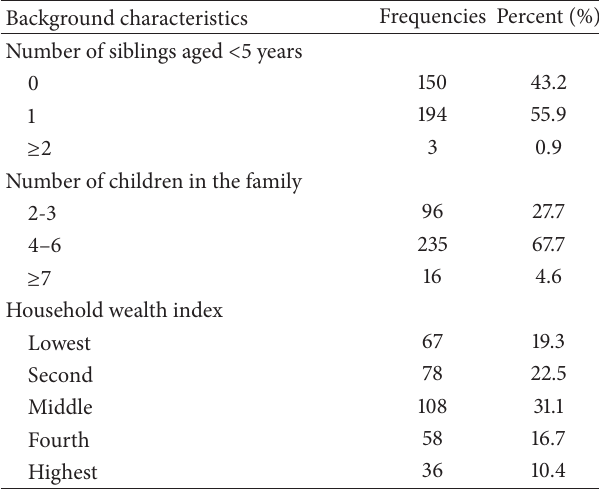
Table 1: Socioeconomic and demographic characteristics of the family and children aged 6–23 months attending growth